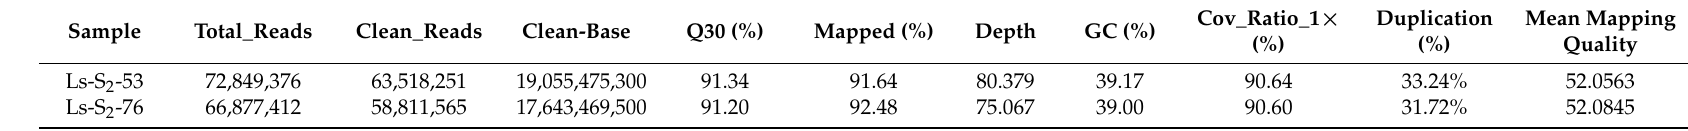
Table 3. Statistical analysis of resequencing data for F. viridis sequencing samples Ls-S 2 -76 and Ls-S 2